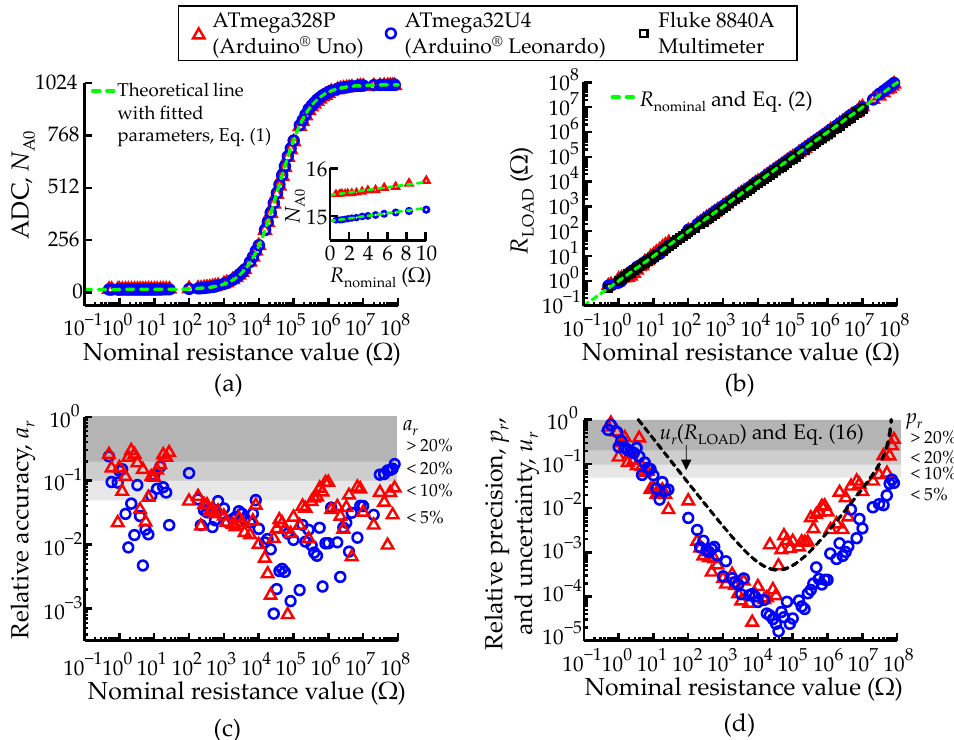
Figure 8. Comparison between the ATmega328P and ATmega32U4 AVR ® micro-controllers configured to record an isolated load resistance ( R LOAD ). ( a ) Measured ADC unit discrete values at port P A0 ( N A0 ). Each sample consists of an average of 100 consecutive measurements. ( b ) Measured load resistance ( R LOAD ) values according to Equation (2). The green dashed lines represent the theoretical lines. ( c ) Relative accuracy ( a r ) and ( d ) relative precision ( p r ) of the measurements in function of R nominal . The black dashed line represents the relative uncertainty ( u r ) of the R LOAD measurements according to Equation (16). The white and grey shading areas highlight the levels of u r , a r and p r better than 5%, 10% and 20%. A legend to describe the color scheme used in all plots of Figure 8 was included.